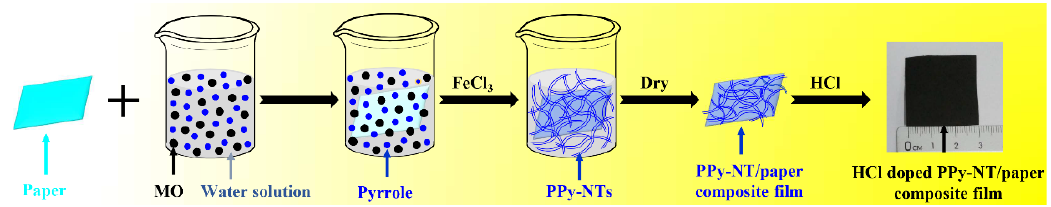
Figure 1. The fabrication process of the polypyrole nanotube (PPy–NT)/paper composite films.